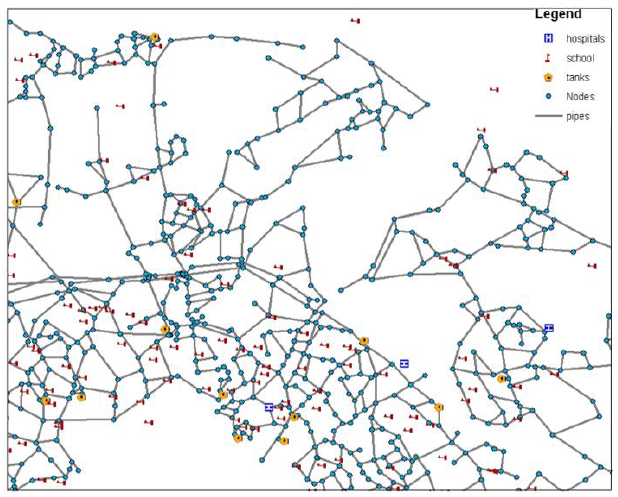
Figure 1. Schematics of a water distribution piping network.